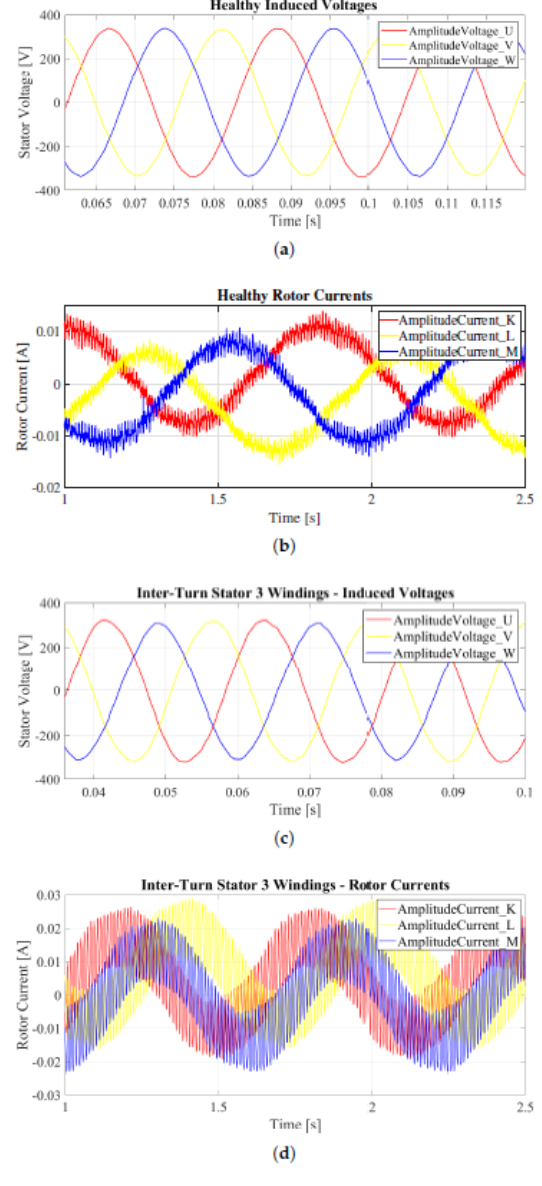
Figure 4. Experimental measurements for, ( a ) stator voltages and ( b ) rotor currents under healthy conditions, and ( c ) stator voltages and ( d ) rotor currents under stator-winding fault conditions, without a